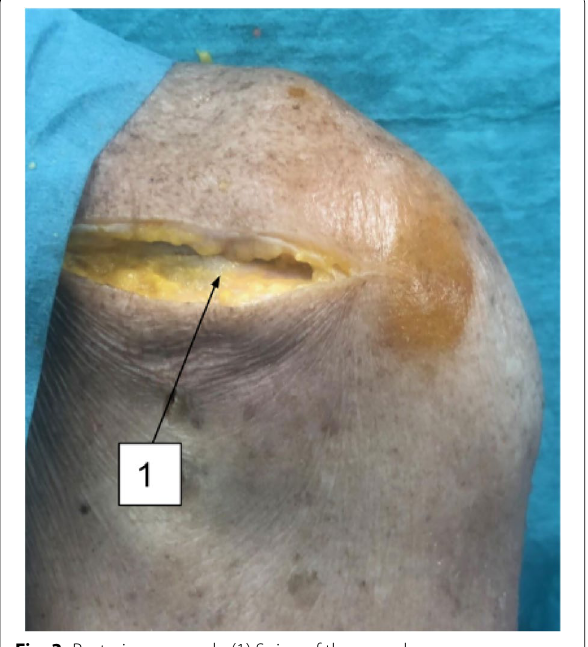
Fig. 3 Posterior approach. (1) Spine of the scapula